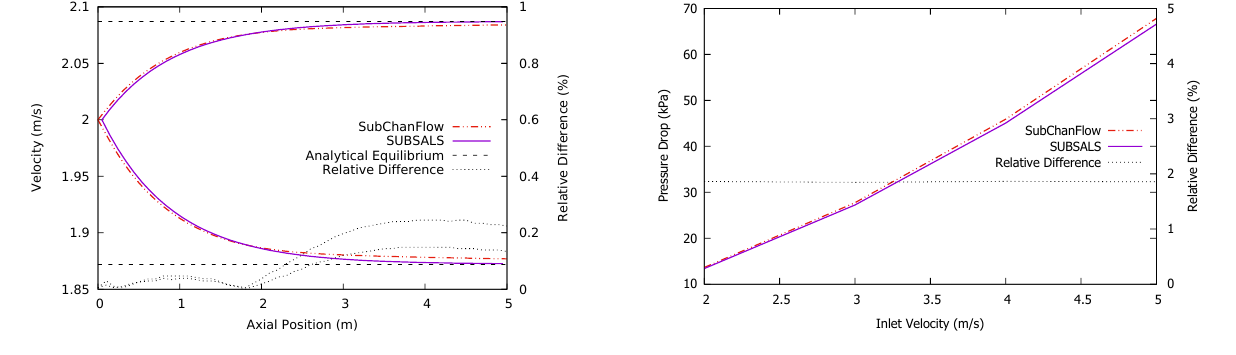
Figure 5. Comparison of pressure drop